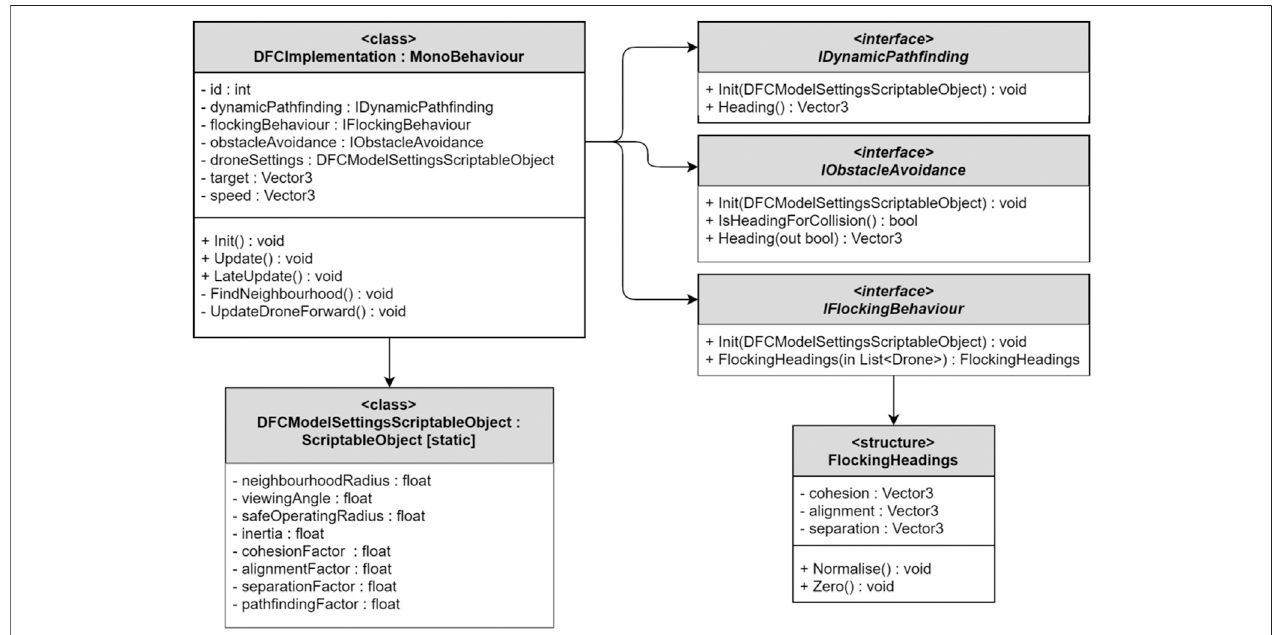
FIGURE 1 | UML diagram for DFC